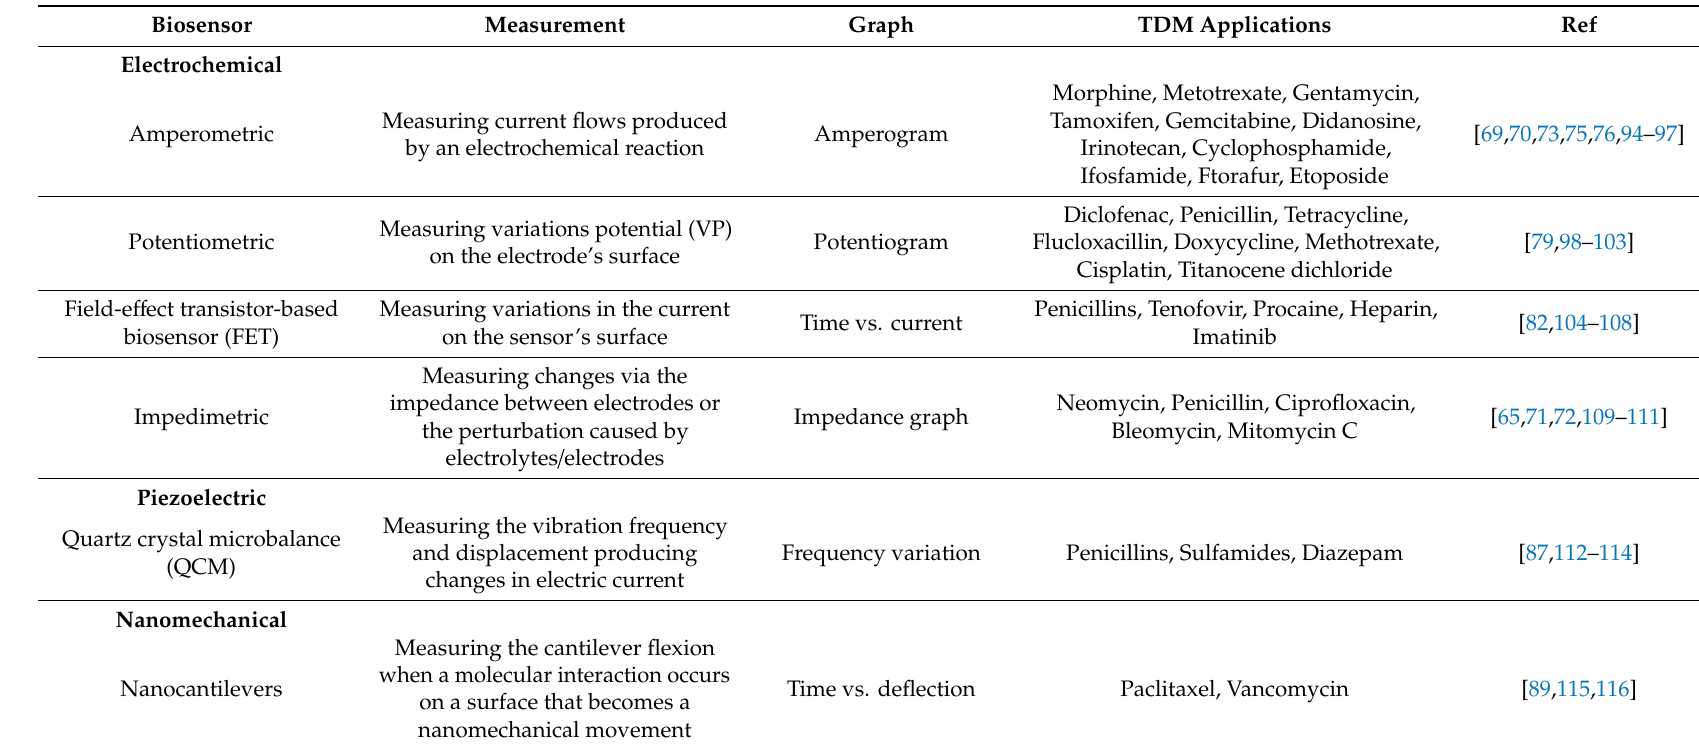
Table 1. Biosensors’ general